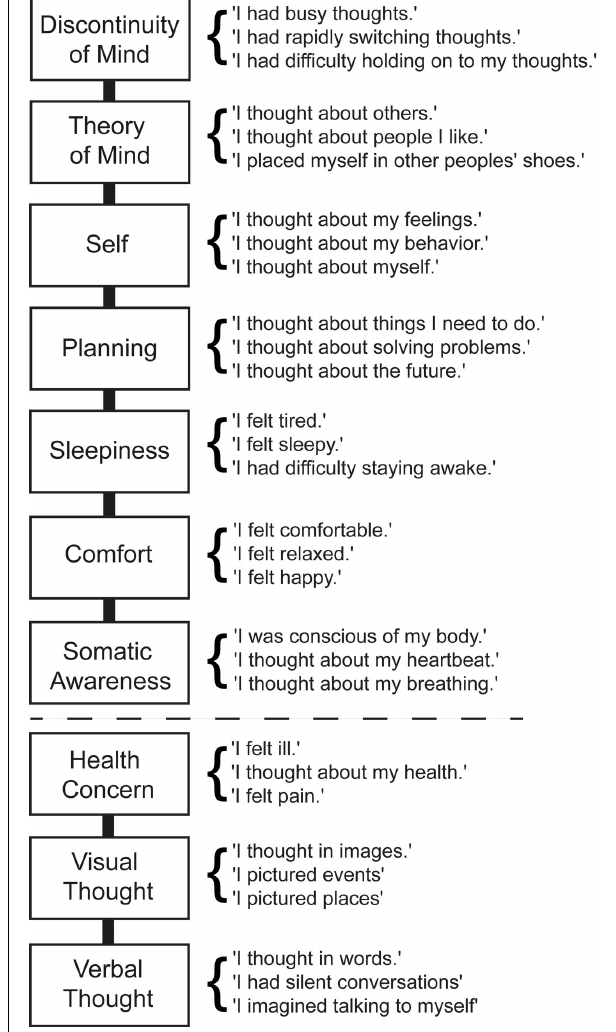
FIGURE 1 | Ten-factor model of mind wandering derived from the Amsterdam Resting-State Questionnaire. The existing model of ARSQ-derived mind-wandering factors (above dashed line, Diaz et al., 2013) can be simplified by reducing the number of items per factor to three. Newly added dimensions tap into verbal and visual thought and “Health